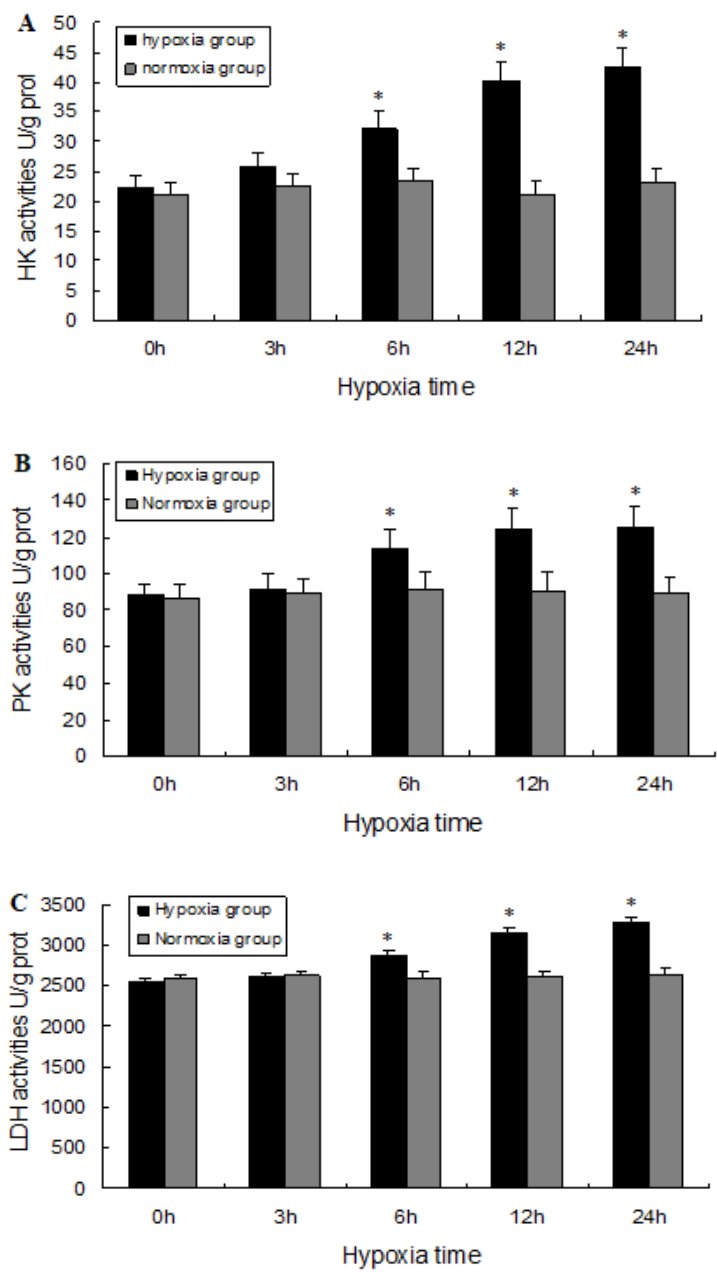
Figure 6. Enzyme activity of hexokinase (HK, A ), pyruvate kinase (PK, B ), and lactate dehydrogenase (LDH, C ) in the brain of prawns in response to hypoxia. Values are presented as mean ± SEM for triplicate samples. Bars with asterisks indicate significant differences between the control and hypoxia groups ( p < 0.05).